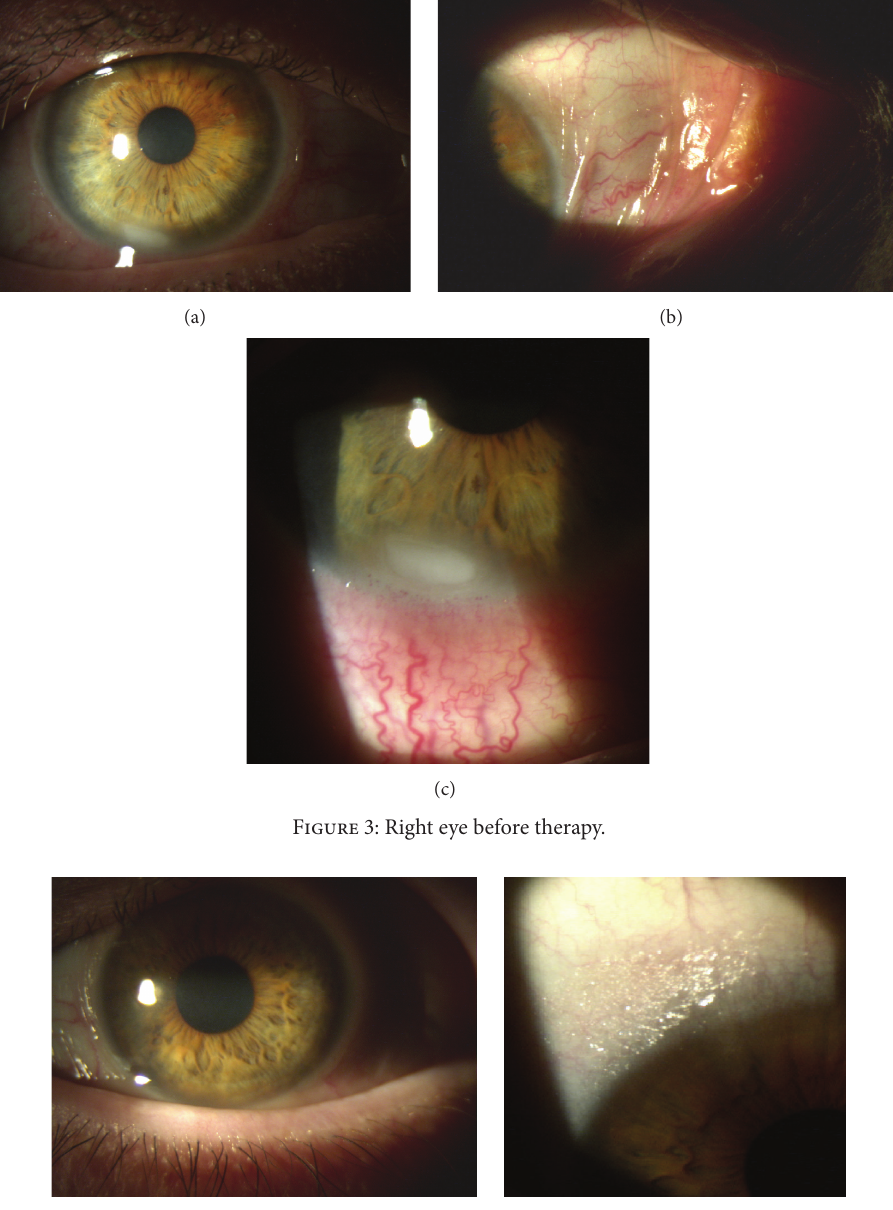
Figure 3: Right eye before therapy.